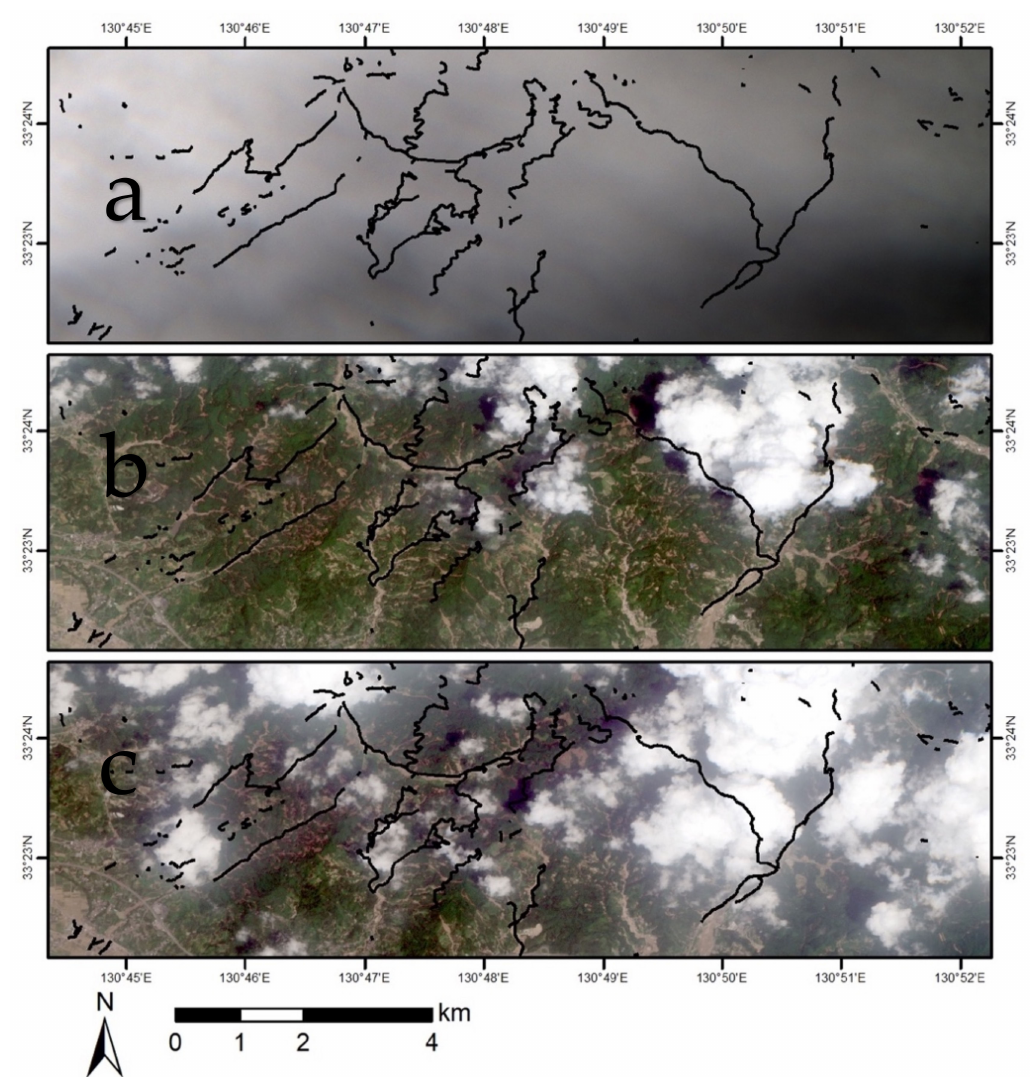
Figure 11. Sentinel-2A / B MSI true-color composite images acquired in the month of July 2017 after the torrential rain event. The extent of the images corresponds to the white line boxed region in Figure 5. The landslide areas are shown as red polygons in ( a ) and the damaged roads are shown as black lines in ( a – c ) for reference Sentinel-2A / B MSI (the GSI, https: // www.gsi.go.jp / common / 000194860.zip). The map was created with ArcGIS ® software (ArcMapTM 10.6.1, Esri, Redlands, CA, USA, http: //